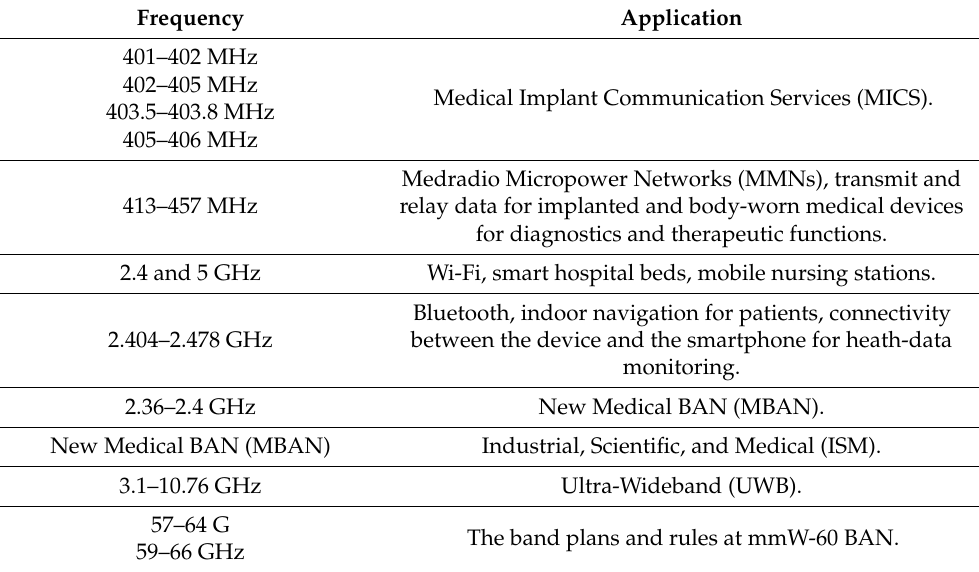
Table 4. A wide variety of frequencies used when dealing with networks and antennas in wearable devices